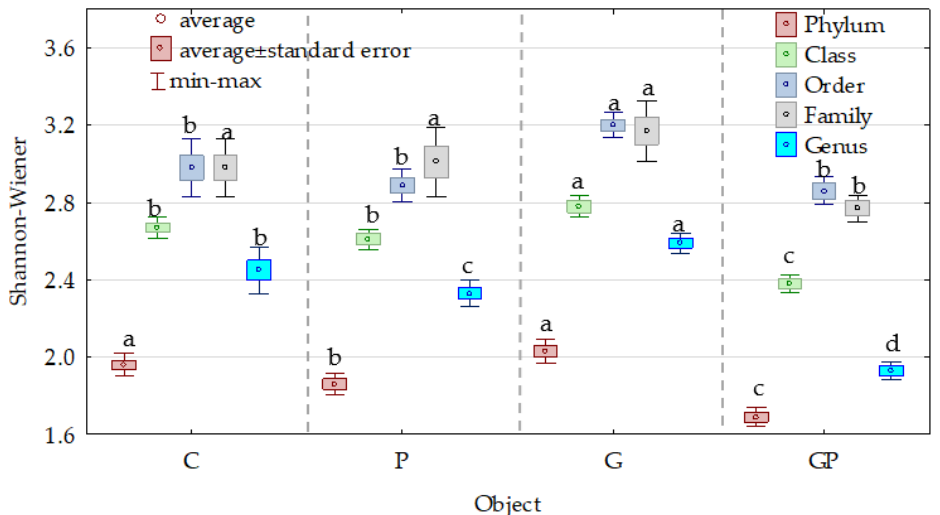
GP — soil polluted with petrol and sown with cocksfoot.